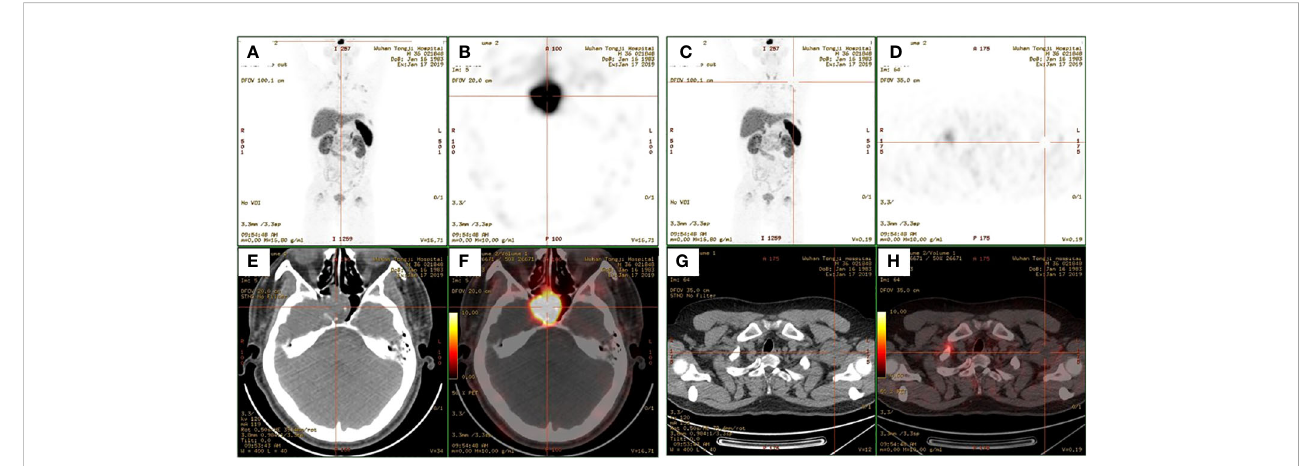
FIGURE 2 (A, C) Maximum-intensity projection images of the patient. (B, D) Axial views of the sphenoid sinus tumor (B) and the axillary tumor (D) in 68-gallium 1,4,7,10-tetraazacyclododecane-1,4,7,10-tetraacetic acid octreotate (Ga-68-DOTATATE) positron emission tomography (PET). (E, G) Axial views of the sphenoid sinus tumor (E) and the axillary tumor (G) in CT. (F, H) Fusion images.